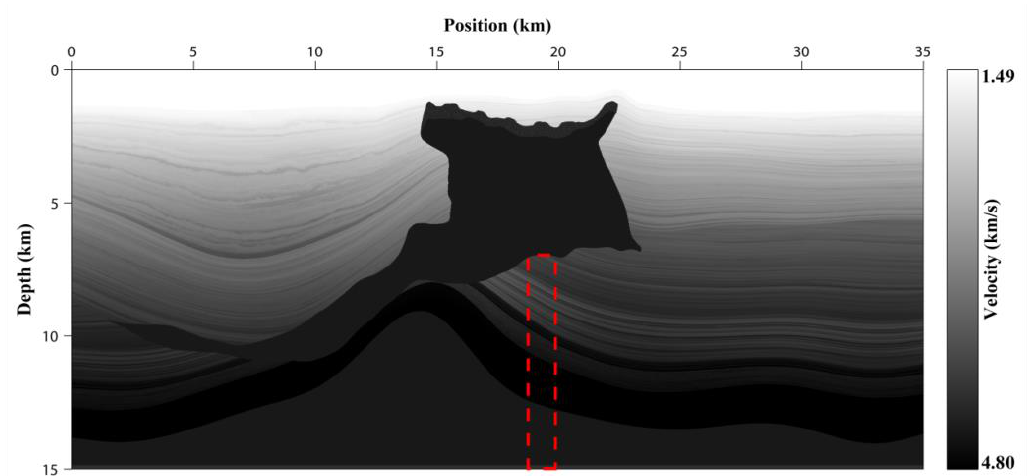
Figure 9. The P-wave velocity model of one section of the SEAM phase I 3D model which used to simulate synthetic shot gathers.